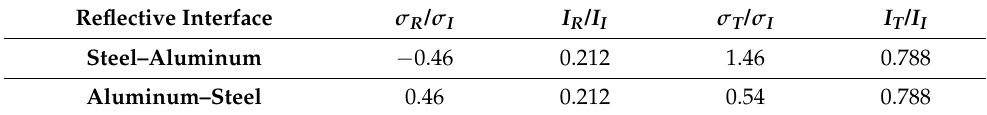
Table 2. Acoustic conduction reflection ratio and transmission ratio of the steel–aluminum